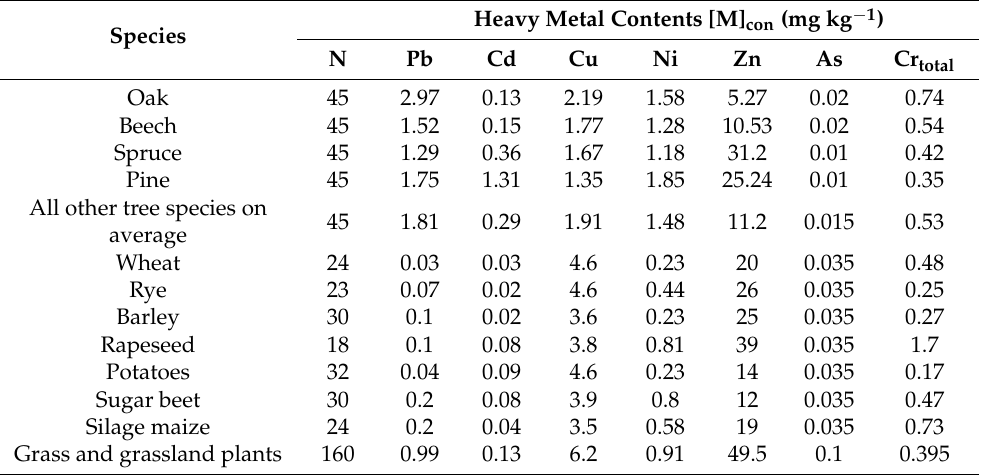
Table 9. Heavy metal contents (mg kg − 1 ) in the dry matter of rough wood with bark of the main tree species, of arable crops and grassland